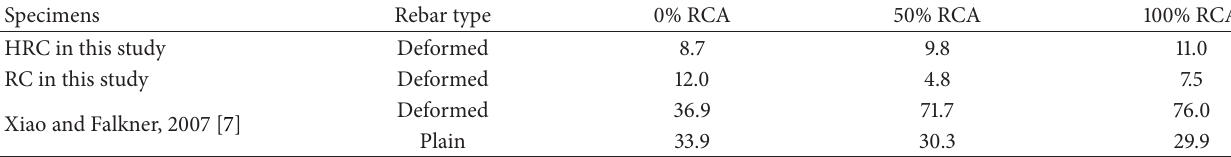
Table 5: 𝐺 values of uncorroded specimens with different RCA content (unit: MPa ⋅ mm).